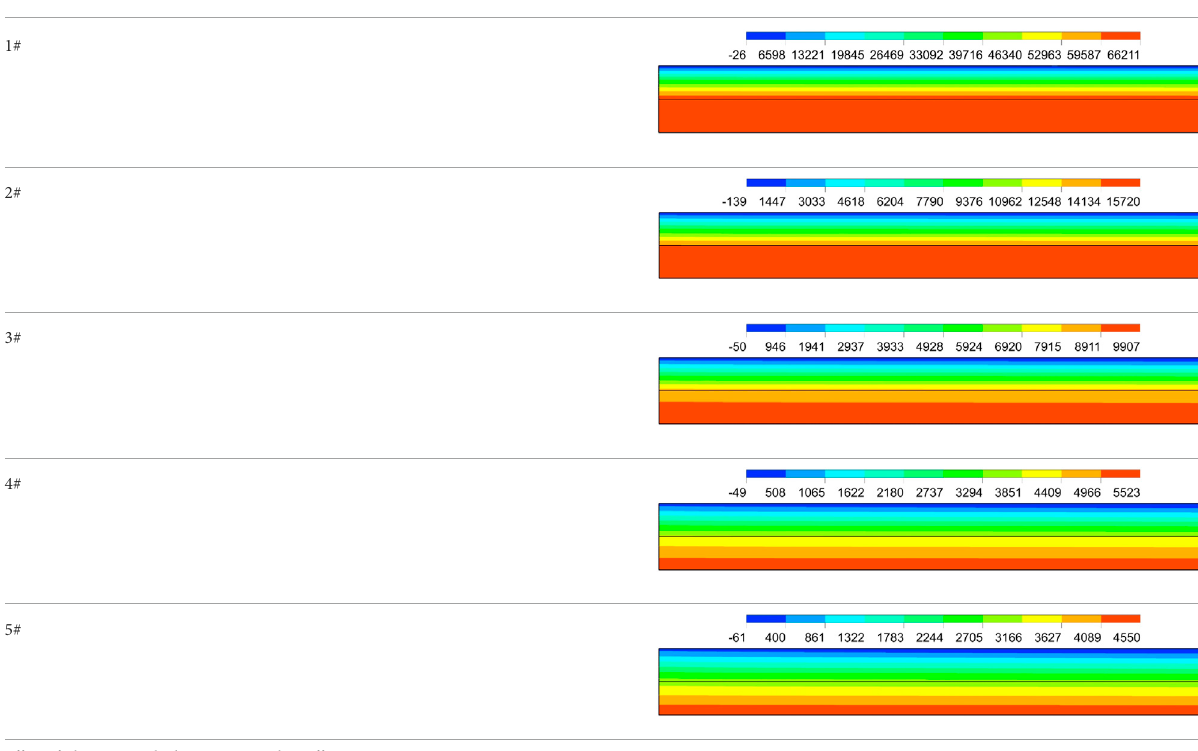
TABLE 4 Pressure distributions in the porous plates. ( F = 1.5%). Test no Pressure distribution